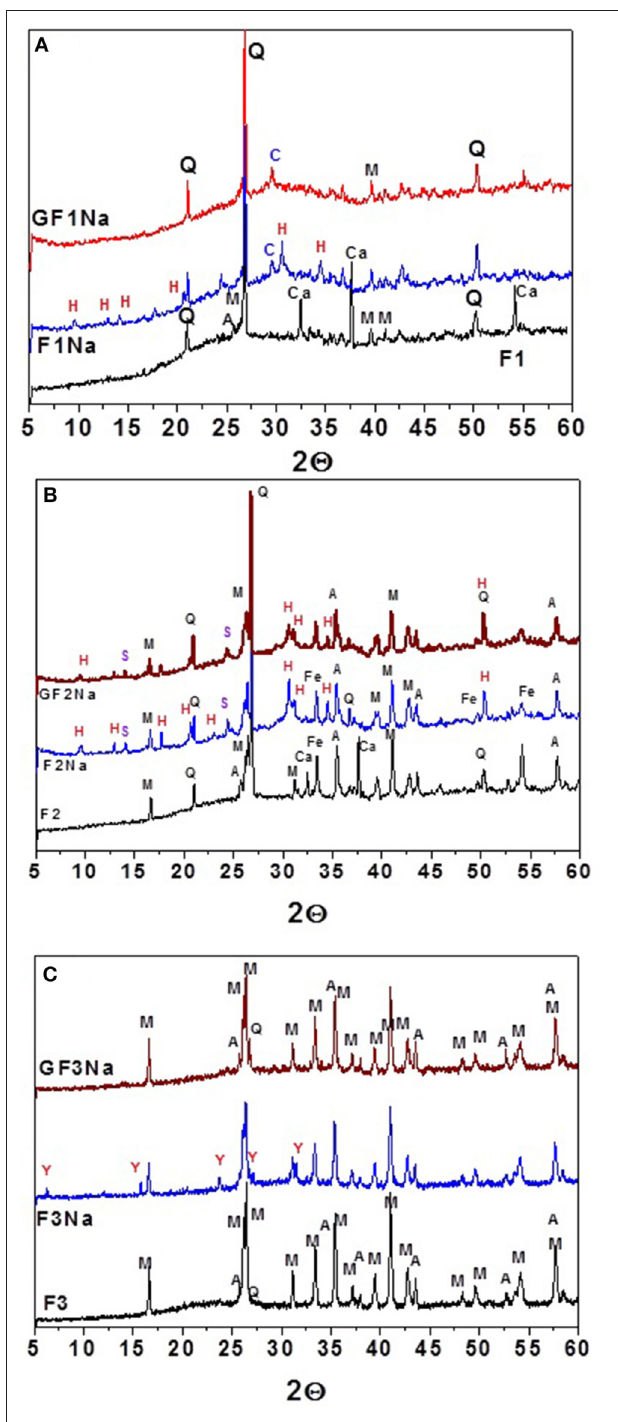
FIGURE 6 | Diffractograms recorded for the starting materials (black patterns), activated original ash (blue patterns) and activated ground ash (red patterns): (A) F1; (B) F2; (C) F3 (Q, quartz-SiO 2 ; M, mullite- Al 6 Si 2 O 13 ; Fe, hematite-Fe 2 O 3 ; Ca, calcium oxide-CaO; A, corundum; C, Calcite; H, herschelite (19-1178) NaAlSi 2 O 6 3H 2 O; S, Hydroxysodalite (11-0401) Na 4 Al 3 Si 3 O 12 (OH); Y, zeolite Y (76-0108)-Na 3.325 H 3.675 Al 7 Si 17 O 48